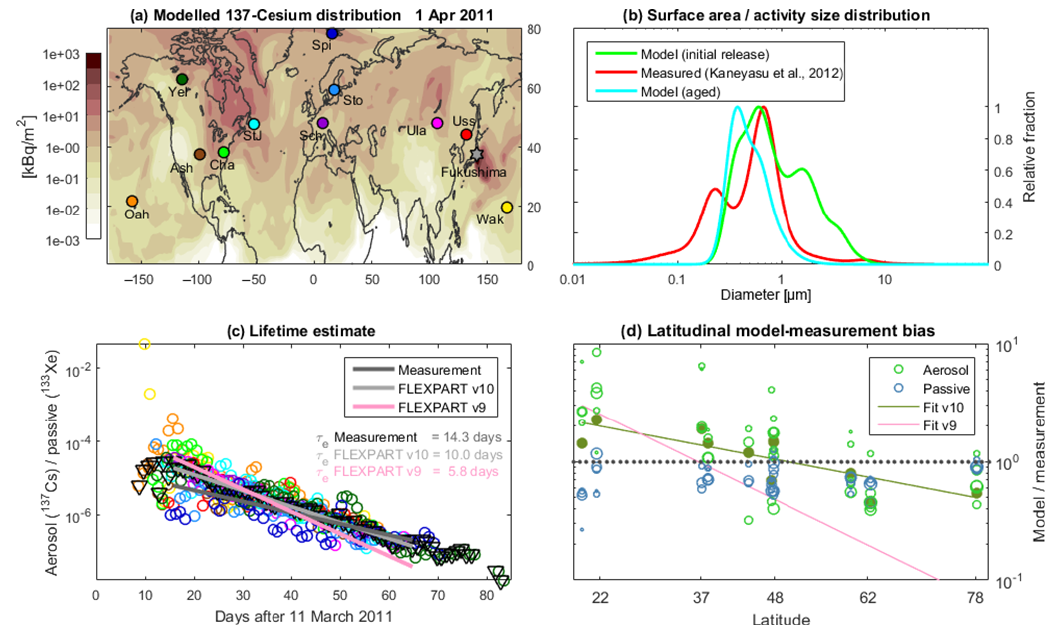
Figure 5. (a) The concentration of 137 Cs in the Northern Hemisphere on day 15 after the initial release. The locations of the observational sites used in this paper are marked with colored circles. (b) Normalized initial (green) and aged (cyan) aerosol surface area distribution of the aerosols used in the simulation. For comparison the measured aerosol size distribution of Kaneyasu et al. (2012) is shown in red. (c) Simulated 137 Cs / 133 Xe concentration ratios for the different stations as a function of time after the accident; upside down black triangles represent median daily ratio values over all stations. The circle colours used for the different stations correspond to those used in panel a. The dark gray line shows the fit to the observed concentrations (see Kristiansen et al., 2016). The light gray line shows the log-linear fit to FLEXPART version 10 model data, and the pink line the fit to version 9 data. (d) Ratio of modeled to observed concentrations as a function of latitude for the passive tracer 133 Xe (blue circles) and the aerosol-bound 137 Cs (green circles). For reference also a 1 : 1 line is shown (dotted black) and a fit to the FLEXPART version 9 data is shown in